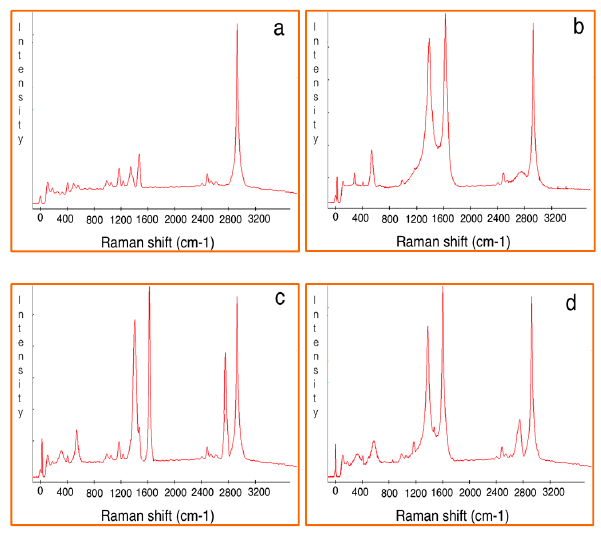
Figure 8. Raman spectroscopy of ( a ) PP; ( b ) CNS/PP; ( c ) CNS-FLG/PP and ( d ) CNS-MLG/PP.